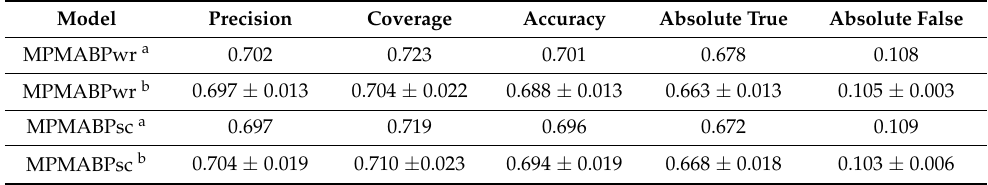
Table 6. The predictive performances of MPMABPwr and MPMABPsc.